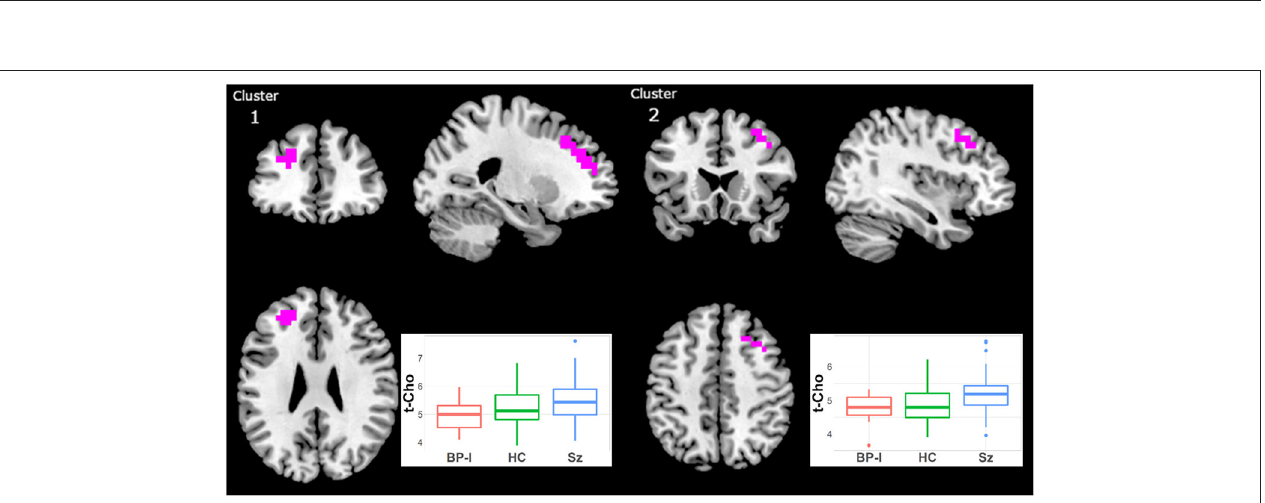
FIGURE 4 | Increased t-Cho in Schizophrenia (Sz) vs. Bipolar-I (BP) (healthy controls [HC] intermediate) in two clusters: (1) 40 voxels, CCLAV = 0.02, including the left superior frontal gyrus (47.3%) and left middle frontal gyrus (39.2%). (2) 29 voxels, CCLAV = 0.03, including the right middle frontal gyrus (47.3%) and the right superior frontal gyrus (14.6%). Boxplots shows weighted-average t-Cho cluster concentrations in institutional